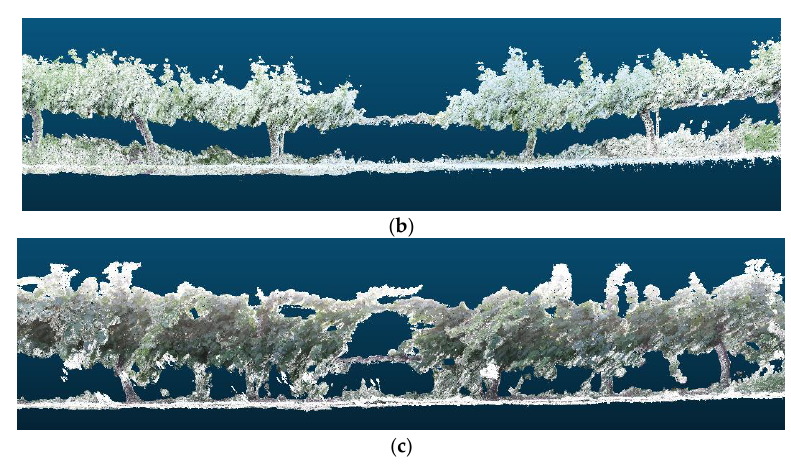
Figure 15. The same view of the 3D reconstruction of a vineyard with the information acquired in: ( a ) February 2016; ( b ) May 2016; and ( c ) July 2016.